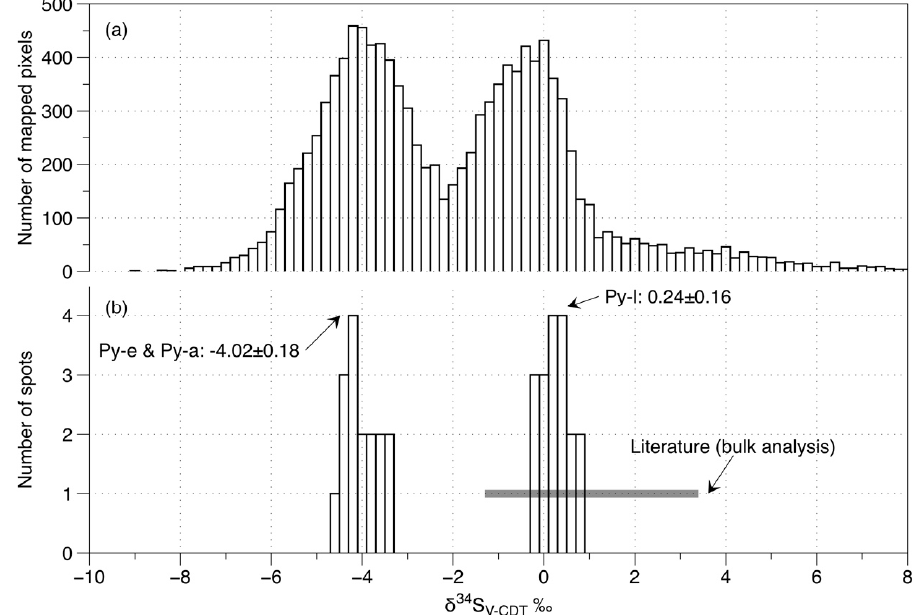
Figure 7. Comparison of S-isotope data from mapping and spot analysis. ( a ) Statistic results of mapping analysis in the Figure 6b; ( b ) Spot analysis results. There is no systematic drift between the statistical results from the two methods. Published data (obtained via traditional bulk analysis methods [40]) are also marked. These cover only the coarser Py-l. The fine-grained Py-e in the matrix had been observed but was not analyzed previously.